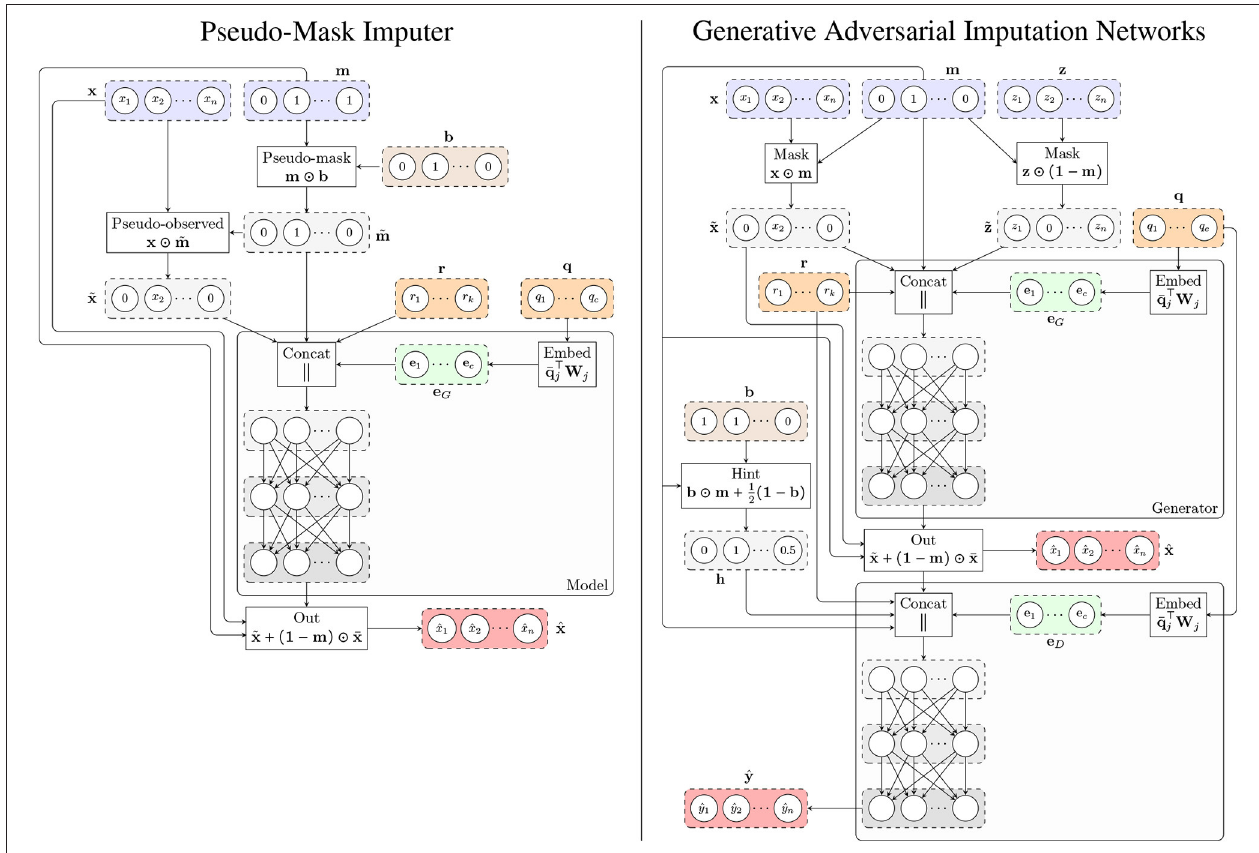
FIGURE 1 | Architecture of the proposed methods. (Left) Pseudo-Mask Imputer (PMI). (Right) Generative Adversarial Imputation Networks for GTEx (GAIN-GTEx). In both cases, the imputer takes gene expression values x with missing components according to a mask m , and categorical (e.g., tissue type; q ) and numerical (e.g., ˜ age; r ) covariates, and outputs the imputed values x . The observed components of the imputer’s output are then replaced by the actual observed expression values ¯ yielding the imputed sample x . For PMI, the pseudo-mask mechanism masks out some of the observed components, which are then recovered at the output. For the ˆ adversarial model (right), we additionally train a discriminator that receives x , the sample covariates, and the hint vector h , and produces the output ˆ y i represents the probability of gene i being observed as opposed to being imputed by the component ˆ